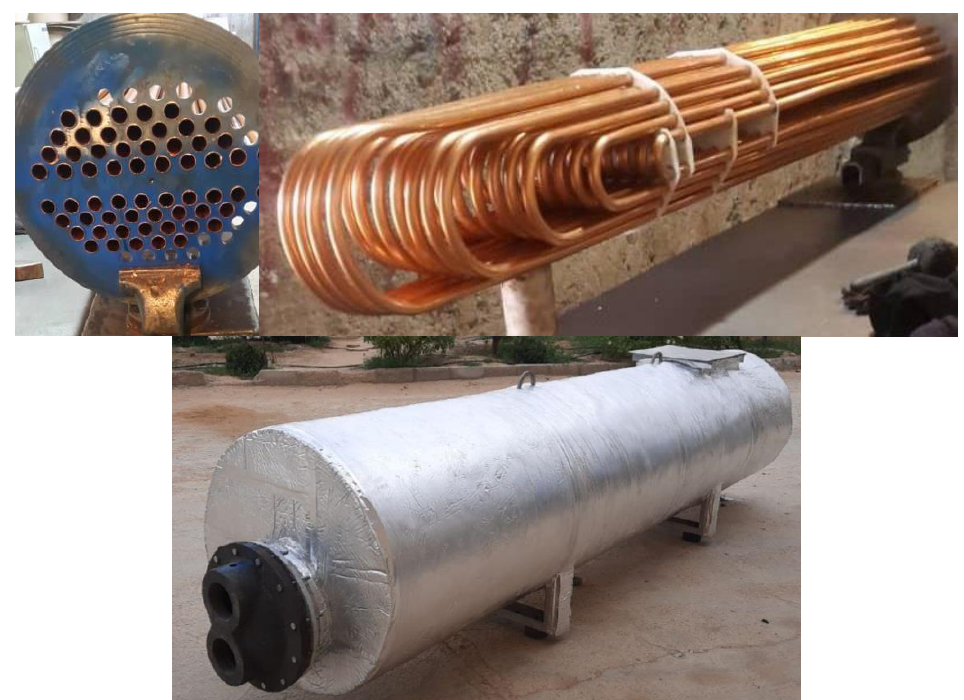
Figure 4. The thermal coil and the fabricated seawater tank.